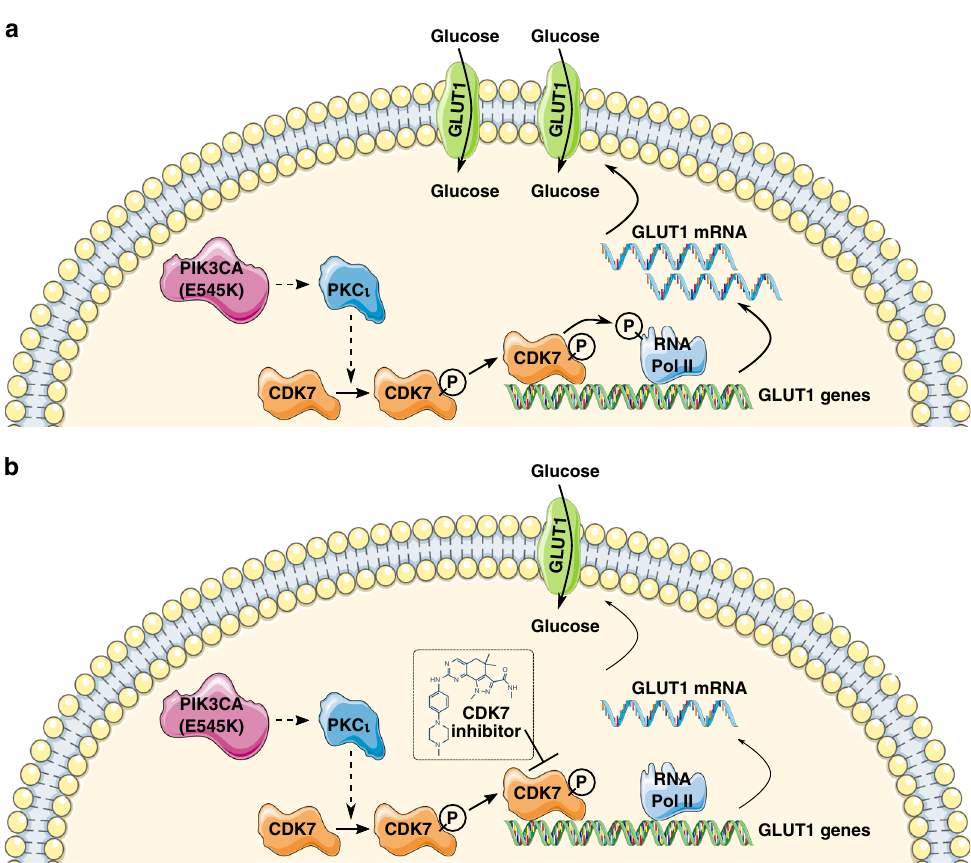
Fig. 8 CDK7 activates glucose transport in certain NSCLC. a Activated PIK3CA signals through PKC ι to induce CDK7 phosphorylation. Phosphorylation of CDK7 activates it to phosphorylate RNA Polymerase II (RNA Pol II). This leads to transcription of GLUT1 mRNA, expression of the GLUT1 transporter, and transport of glucose across the cell membrane. b CDK7 inhibitor treatments block CDK7 activity, decreasing the phosphorylation of RNA Pol II. This leads to a decrease in GLUT1 mRNA and protein levels, and less glucose transport. Dotted lines are meant to represent the regulation of one protein by another but not necessarily a direct, linear interaction between the